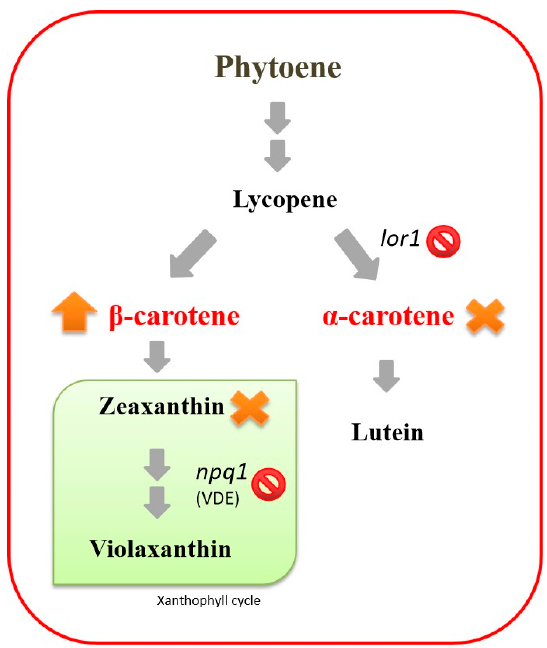
Figure 4. Simplified pathways for carotenoid synthesis and xanthophyll cycle in npq1 lor1 mutant (VDE; violaxanthin de-epoxidase).